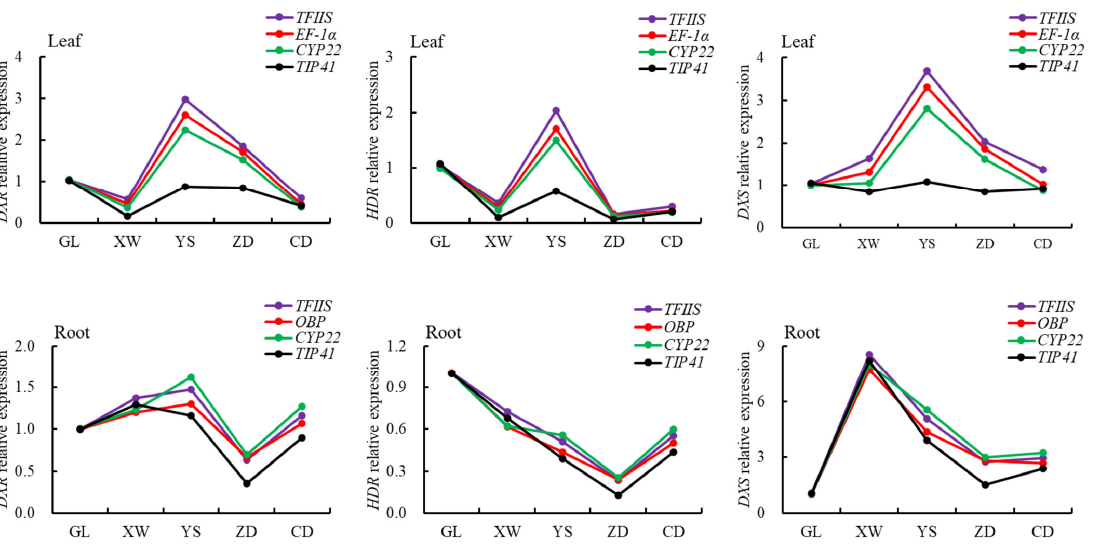
poorly stable internal reference gene ( TIP41 ) from the leaf, were used as the internal ref- erence to study the expression of three genes ( DXR , HDR , and DXS ) related to the synthe- Figure 8, the three genes DXR , HDR , and DXS all showed the same expression change trend in the leaves of L. rotata.